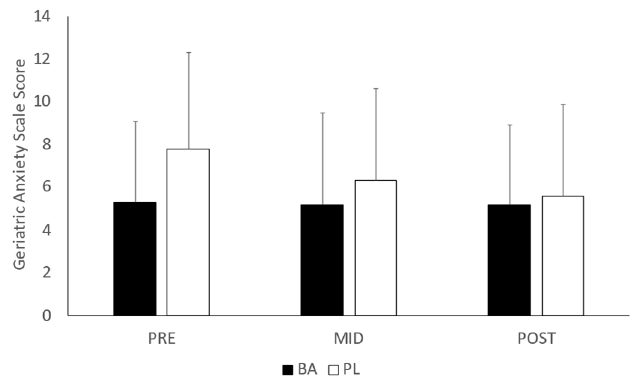
Figure 5. Geriatric Anxiety Scale. BA = β -alanine; PL = Placebo; All results are presented as mean ± SD.